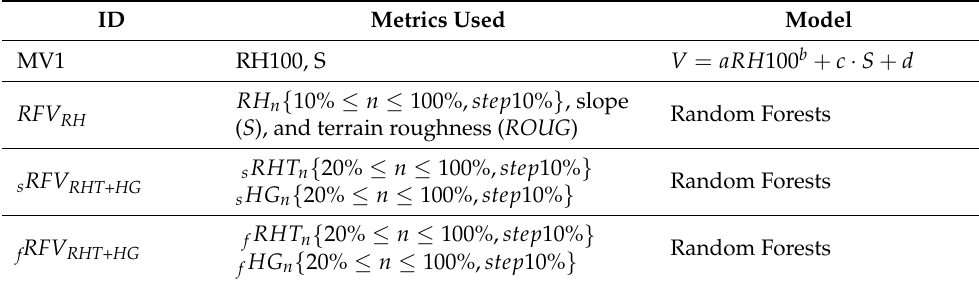
Table 3. List of the models used for the estimation of wood volume (V). ID Metrics Used